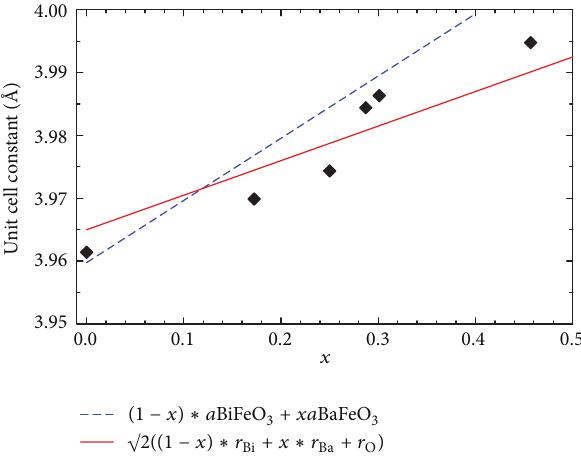
Figure 10: Pseudocubic unit cell parameter of Bi 1−